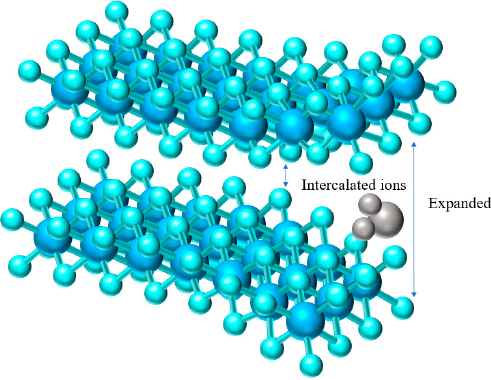
Figure 5. Ion Intercalation in single layer TMDs structure.